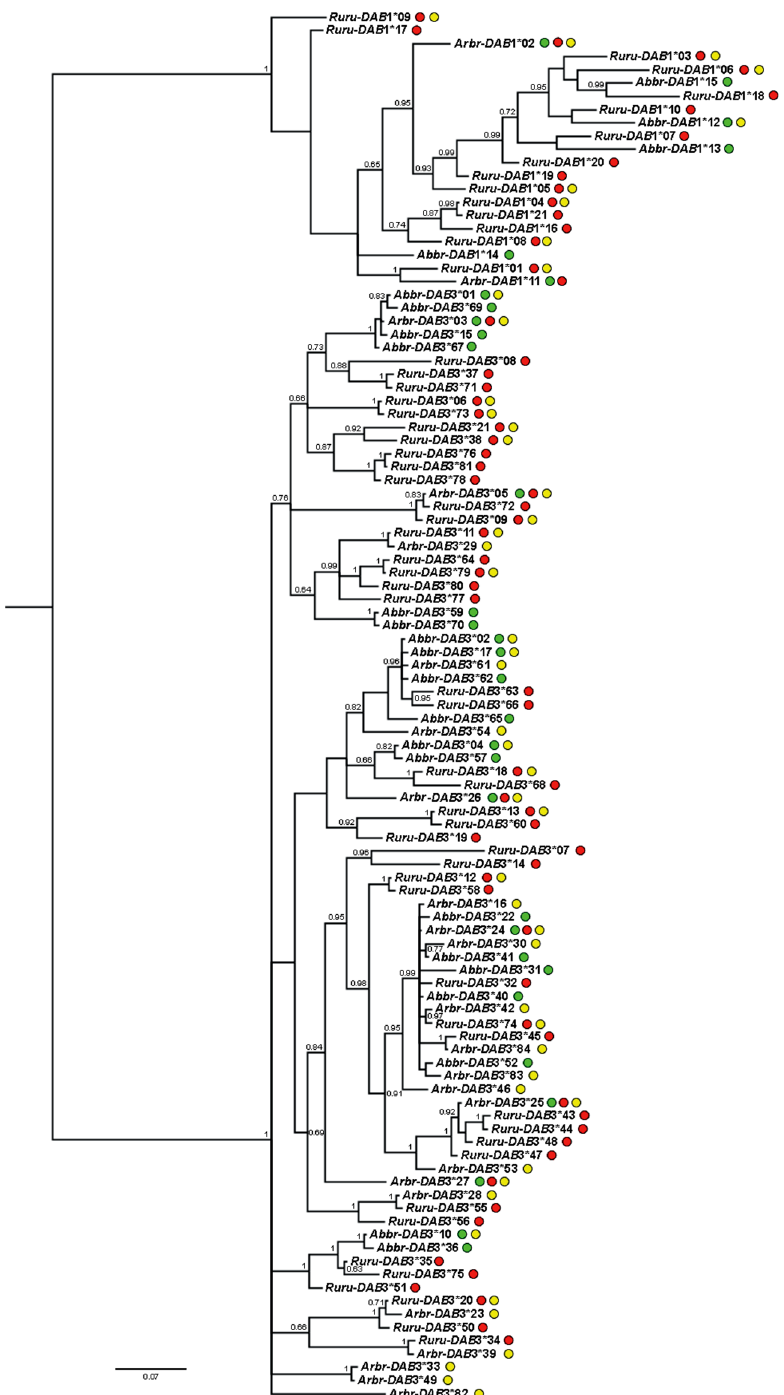
Figure 2. The Bayesian inference tree including DAB1 and DAB3 alleles identified in A. brama , R. rutilus and their hybrids. Numbers along branches represent posterior probabilities (> 0.60) resulting from BI. Green dots indicate the alleles present in A. brama, red dots indicate the alleles present in R. rutilus , and yellow dots indicate the alleles present in hybrids. DAB alleles were abbreviated as follows: Abbr present solely in A. brama or both A. brama and hybrids , Ruru present solely in R. rutilus or both R. rutilus and hybrids, Arbr alleles present in both parental species and hybrids, or alternatively present solely in